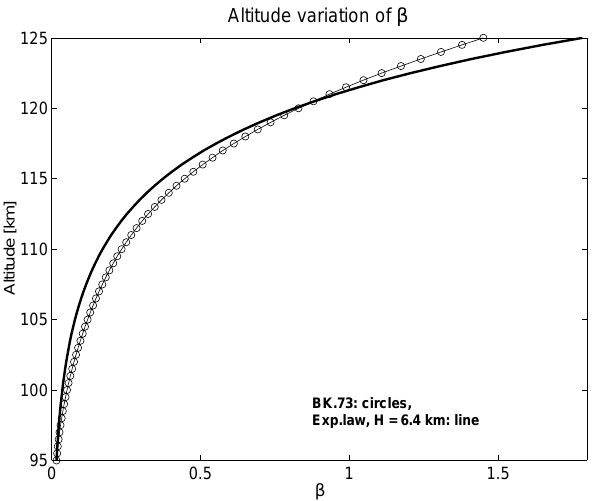
Fig. 1. Altitude dependence of β = (cid:127) i /ν i for two cases: 1. col- lision frequency given by Banks and Kockarts, 1973 (circles), with MSIS-90 (15 July) used for the neutral densities; 2. the same quan- tity expressed using an exponential law with a constant H (line).